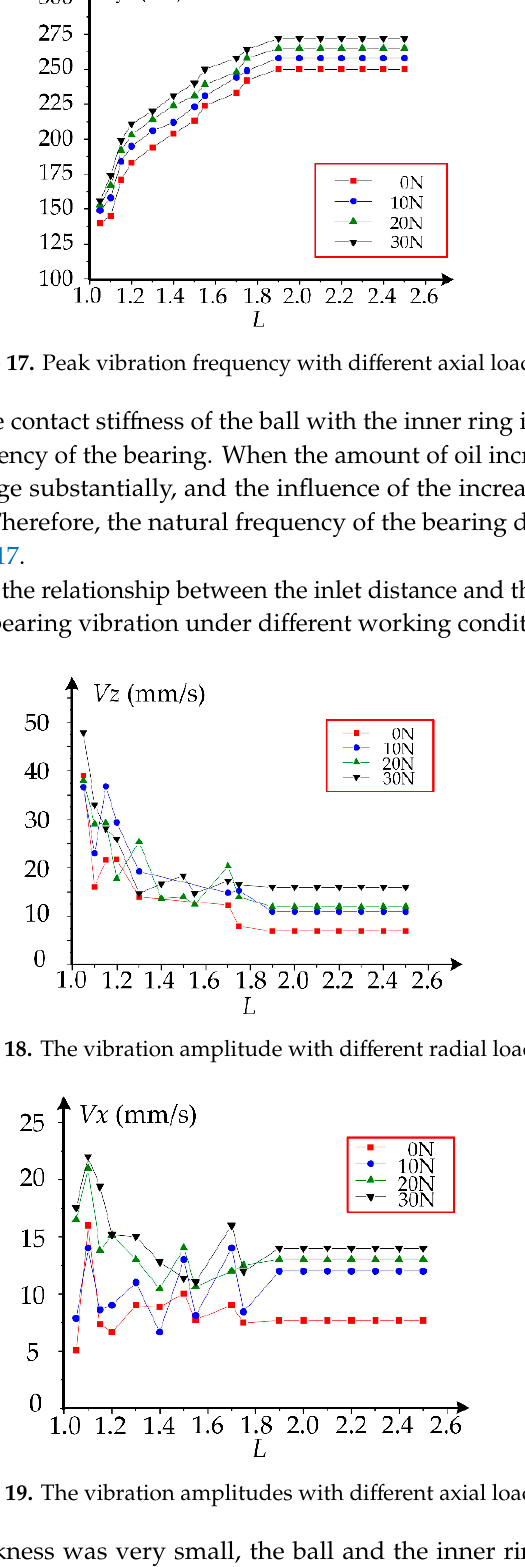
Figure 17. Peak vibration frequency with different axial loads.